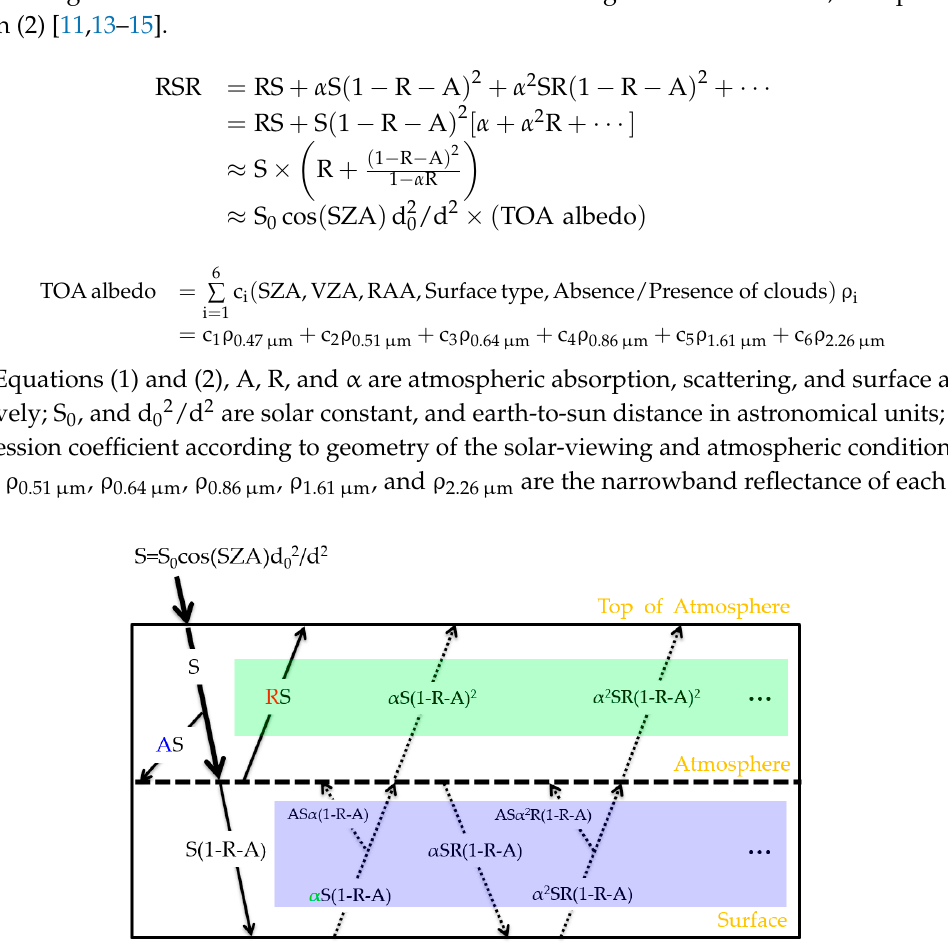
Figure 1. Schematic representing the RSR (green area) in the one-layer solar radiation model. The line at the top of the atmosphere represents the atmospheric contribution (red) associated with cloud reflection, and the dotted line indicates the surface contribution (blue area) associated with surface reflection. The variables A, R, and α are atmospheric absorption and scattering of extraterrestrial solar irradiation, reflection by clouds, and surface albedo, respectively.